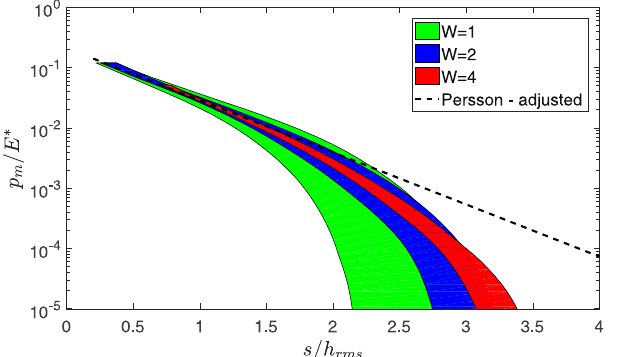
Figure 4. The shaded areas represent load separation curves for H = 0.8, ζ = 64, and W = [1, 2,